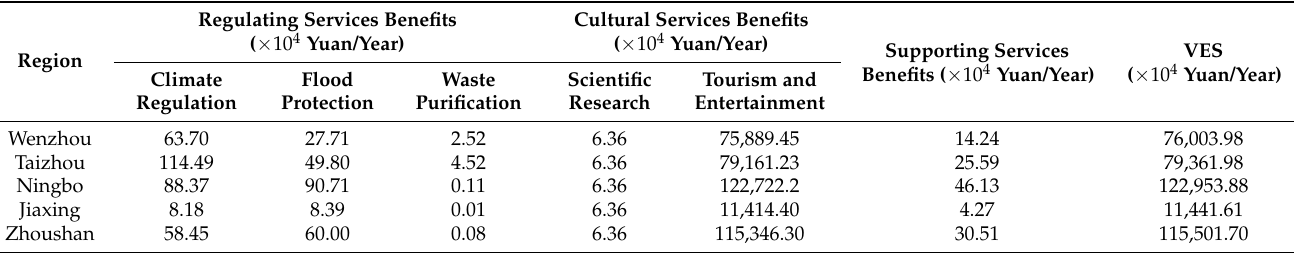
Table 4. The valuation results of the VES in Zhejiang’s five coastal cities after the coastline ecological restoration